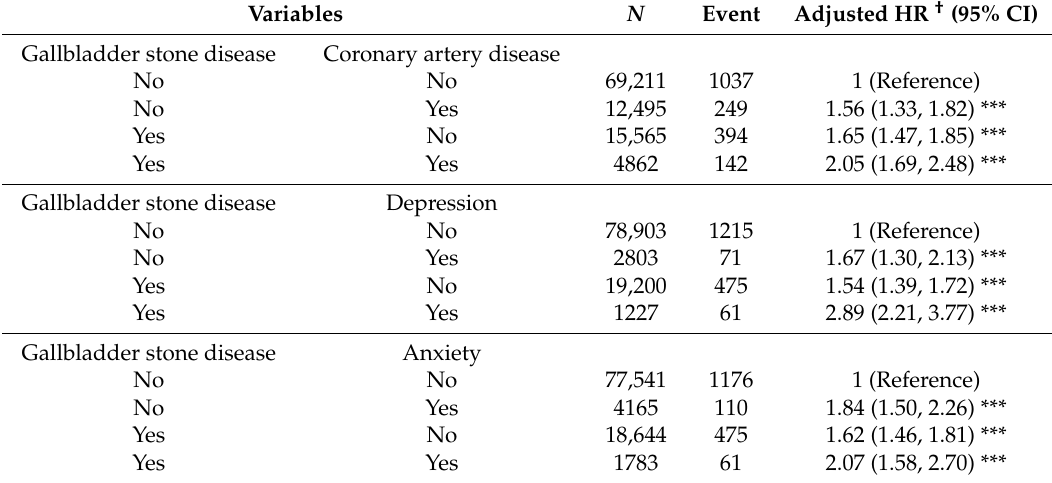
Table 4. Cox proportional hazard regression analysis for the risk of migraine-associated gallbladder stone disease with joint effects of comorbidity.